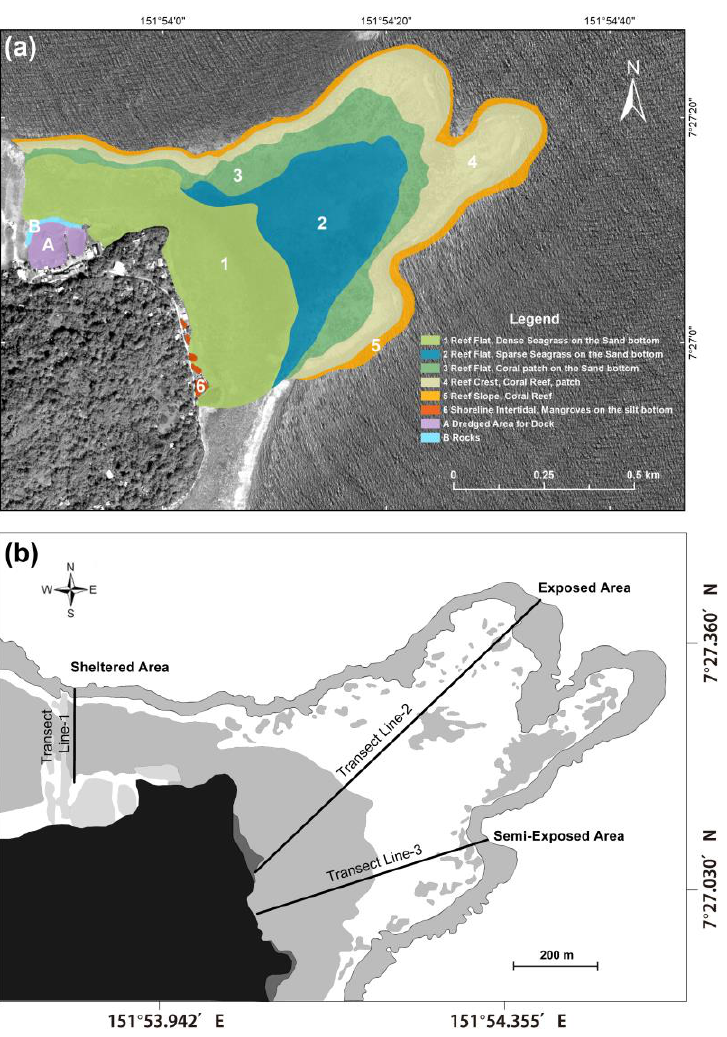
Figure 2. Sampling area. ( a ) Boundary of habitat types as determined manually. ( b ) Location of the three transect lines for habitat investigation by photo-quadrats.